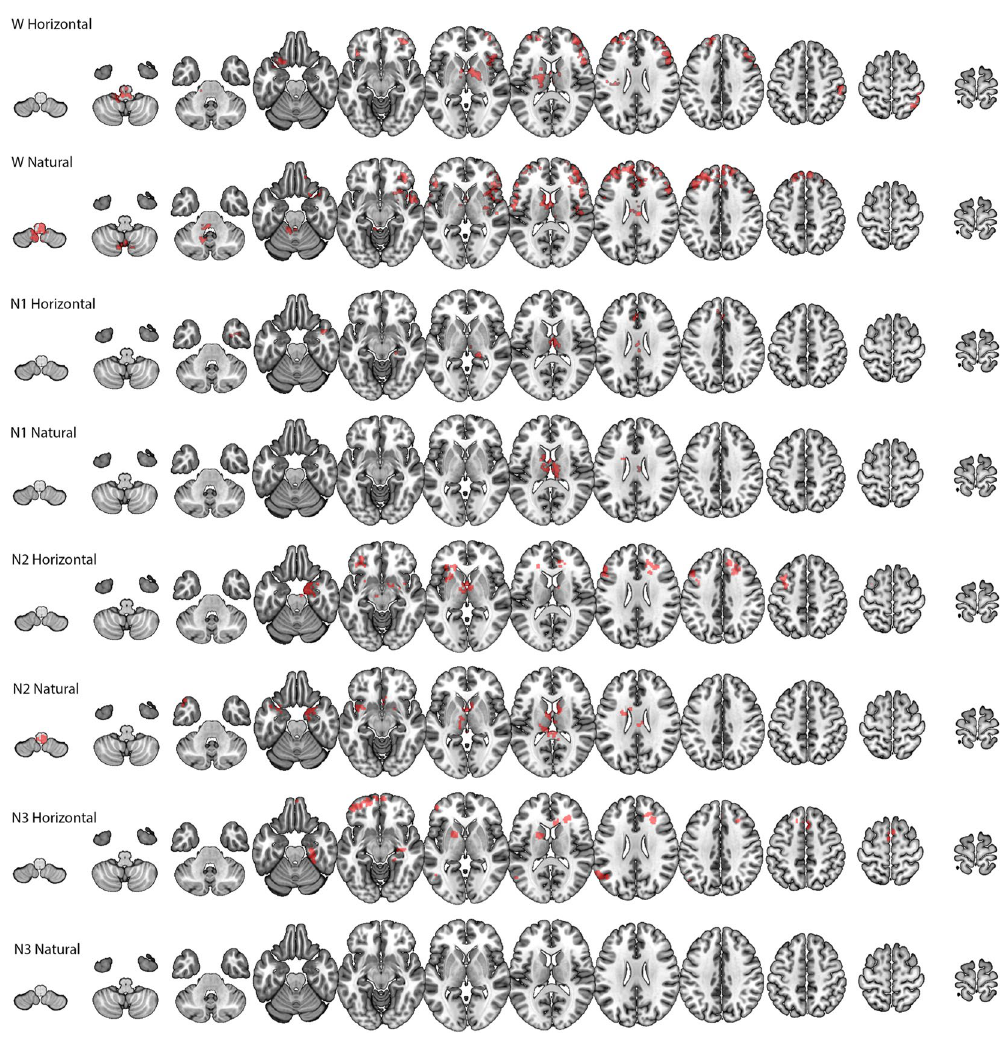
Figure 5. For wakefulness (W) and each sleep stage (N1, N2, N3), the figure shows brain regions for which the degree distributions of the top and bottom graphs differed significantly as determined by an ANOVA repeated- measures analysis across participants. Horizontal = derivation from HVG; Natural = derivation from VG. Images were generated using Neuroimaging FSL software.